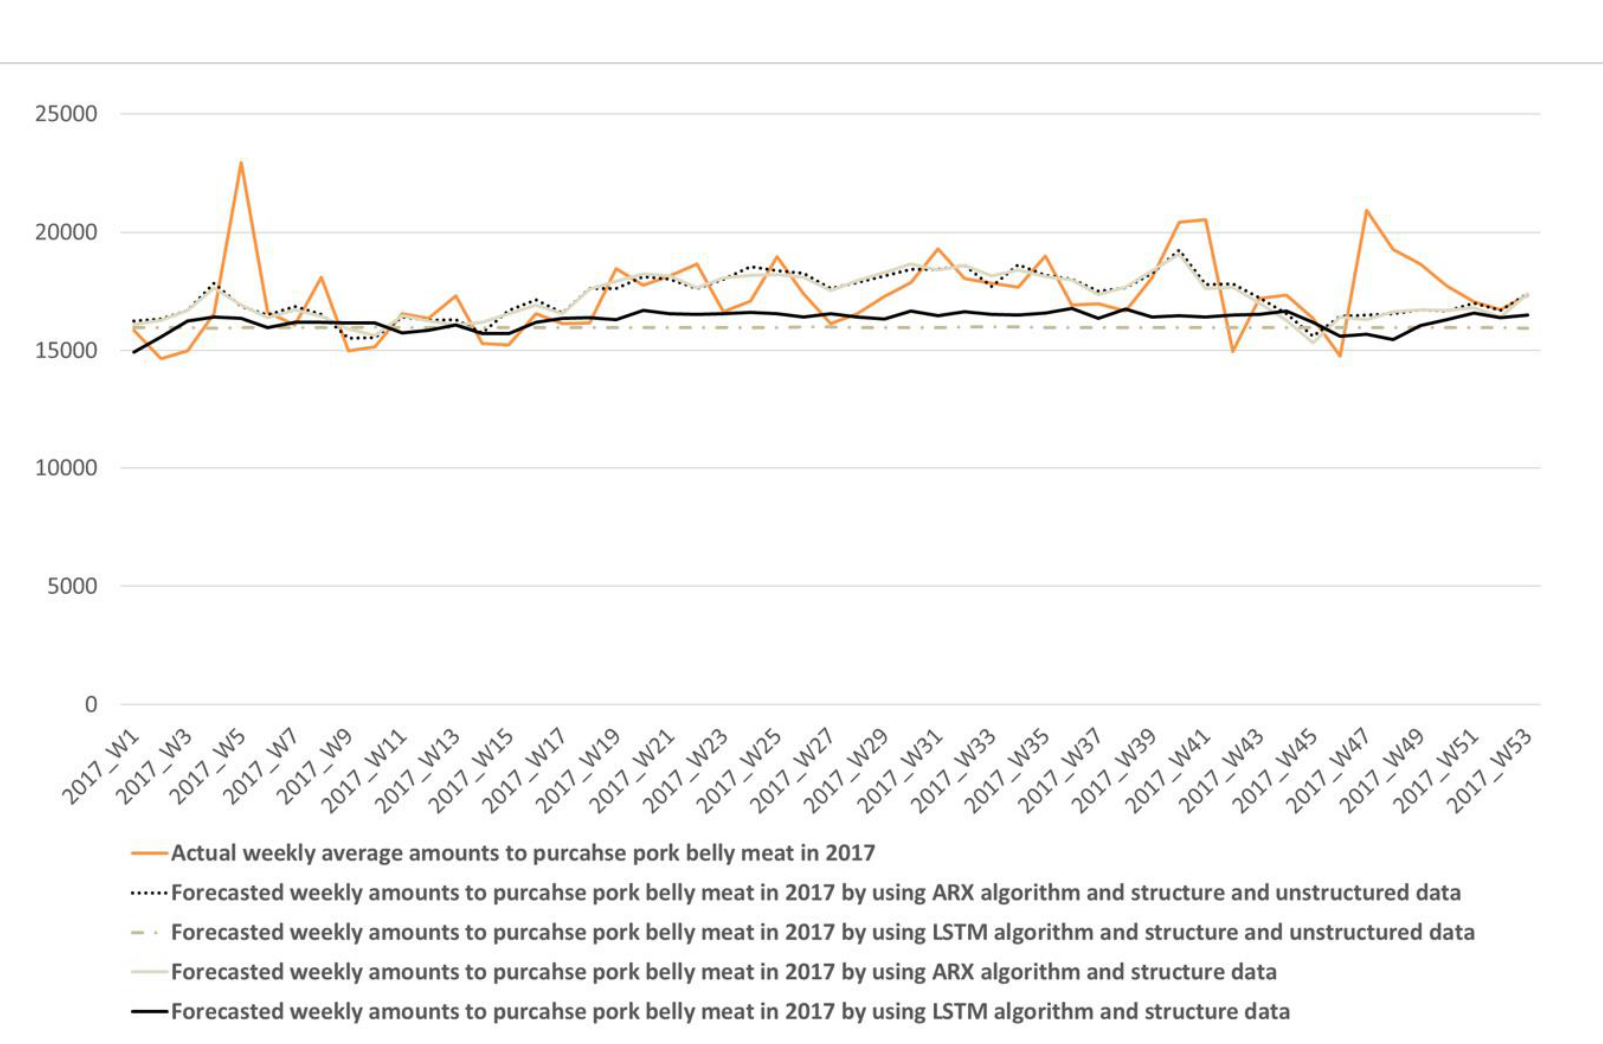
Figure 5. Comparison of forecasted weekly amounts to purchase pork belly meat in 2017.